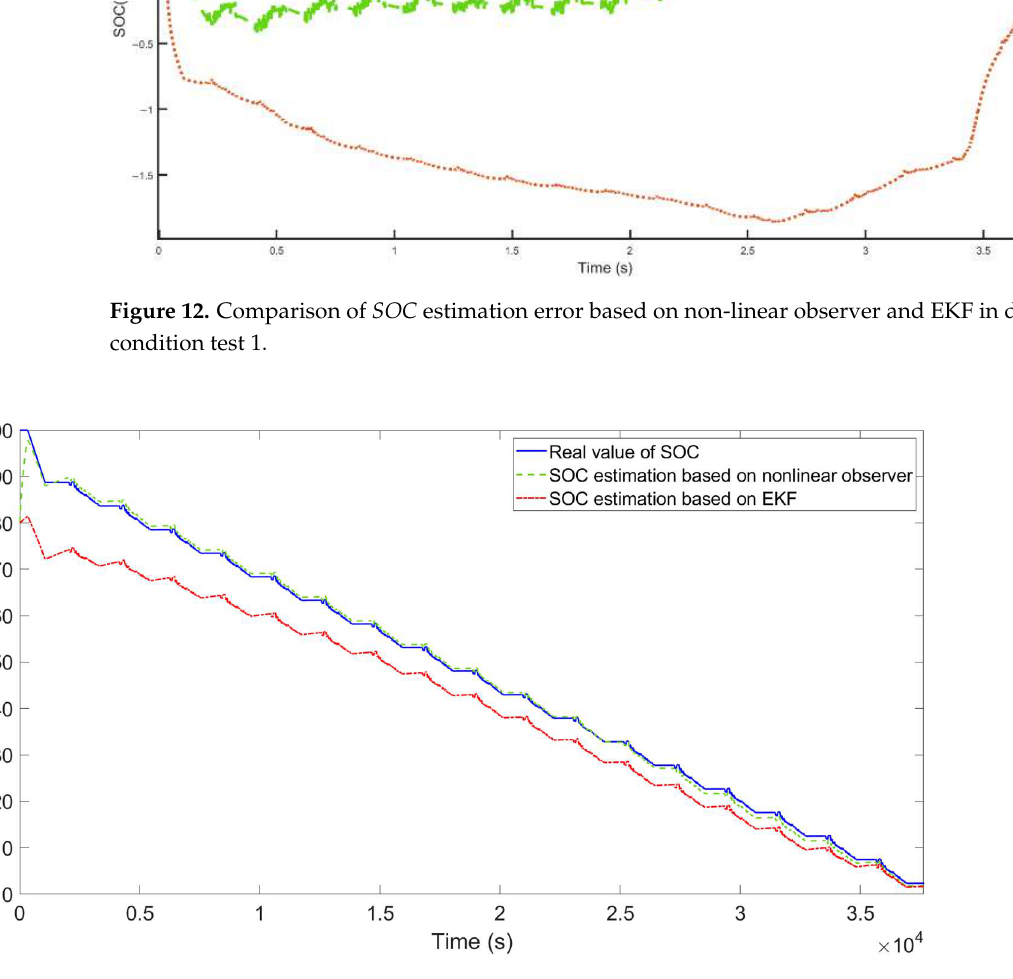
Figure 14. Comparison of SOC estimation based on non-linear observer and EKF in dynamic con- dition test 1 under random SOC initial value. Remark 3. The effects of the number of ganglion points on the performance and calculation of SOC estimation for lithium-ion power batteries based on an RBF neural network non-linear observer were studied through comparative experiments and simulations. More specifically, two, five, seven, eleven and fifteen lithium-ion power batteries were compared to estimate their SOC performance and load using the experimental data of battery current and end voltage collected. The performance comparison of the RBF neural network non-linear observers with different ganglion points for es- timating SOC is shown in Figure 15. The running time for solving the non-linear observer problem of RBF neural networks with different number of ganglion points is shown in Figure 16 to represent